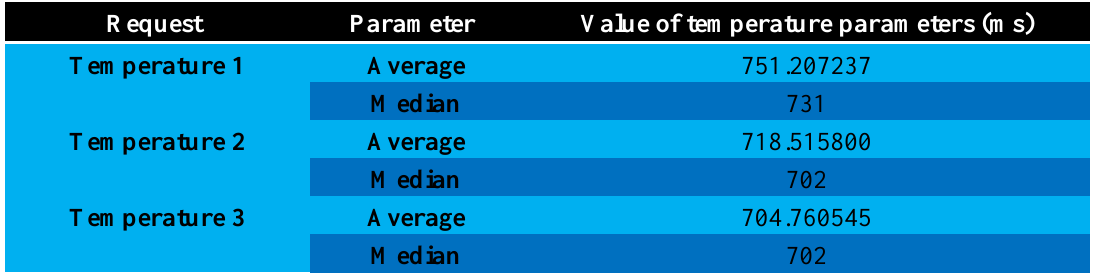
Table 4. Most significant measures obtained for Temperature services.